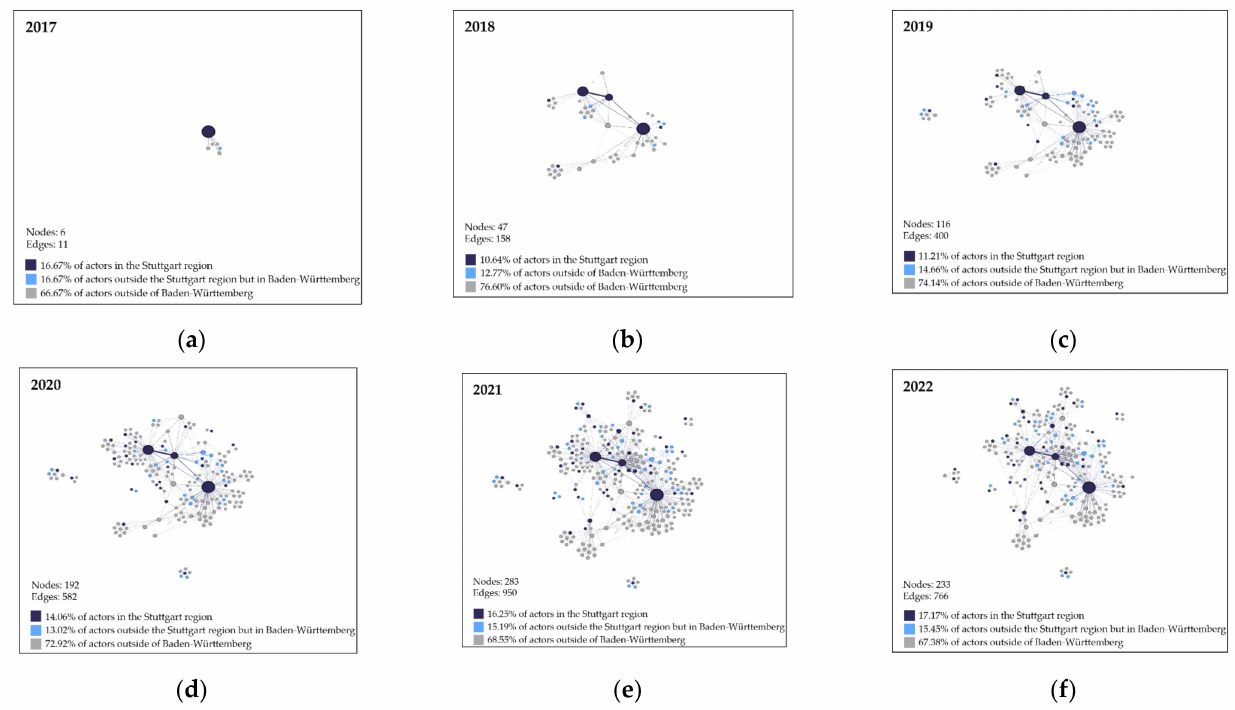
Figure 7. Dynamic representation of the supra-regional bioeconomy network: ( a ) supra-regional bioeconomy network in 2017; ( b ) supra-regional bioeconomy network in 2018; ( c ) supra-regional bioeconomy network in 2019; ( d ) supra-regional bioeconomy network in 2020; ( e ) supra-regional bioeconomy network in 2021; ( f ) supra-regional bioeconomy network in